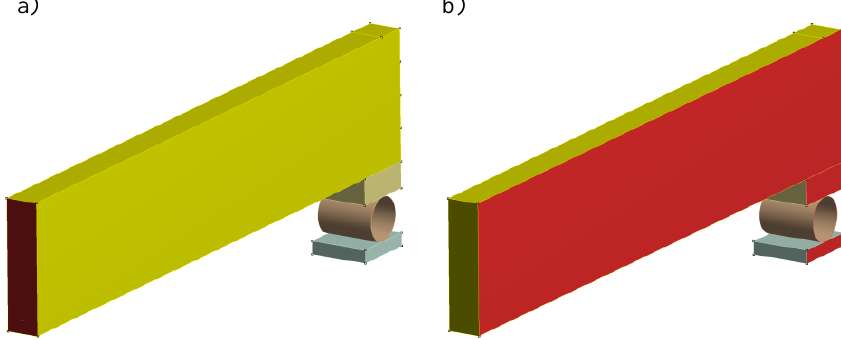
Fig. 2. Symmetry planes (in red): a – transverse; b – longitudinal In cases of calculation of structures subjected to bending and compression the first stage provided application and retention of longitudinal force (Fig. 3a) which is applied as evenly distributed load along the entire side surface of the beam and equals (0; 0.2; 0.4) R bn , where R bn is characteristic compressive strength of concrete (MPa).